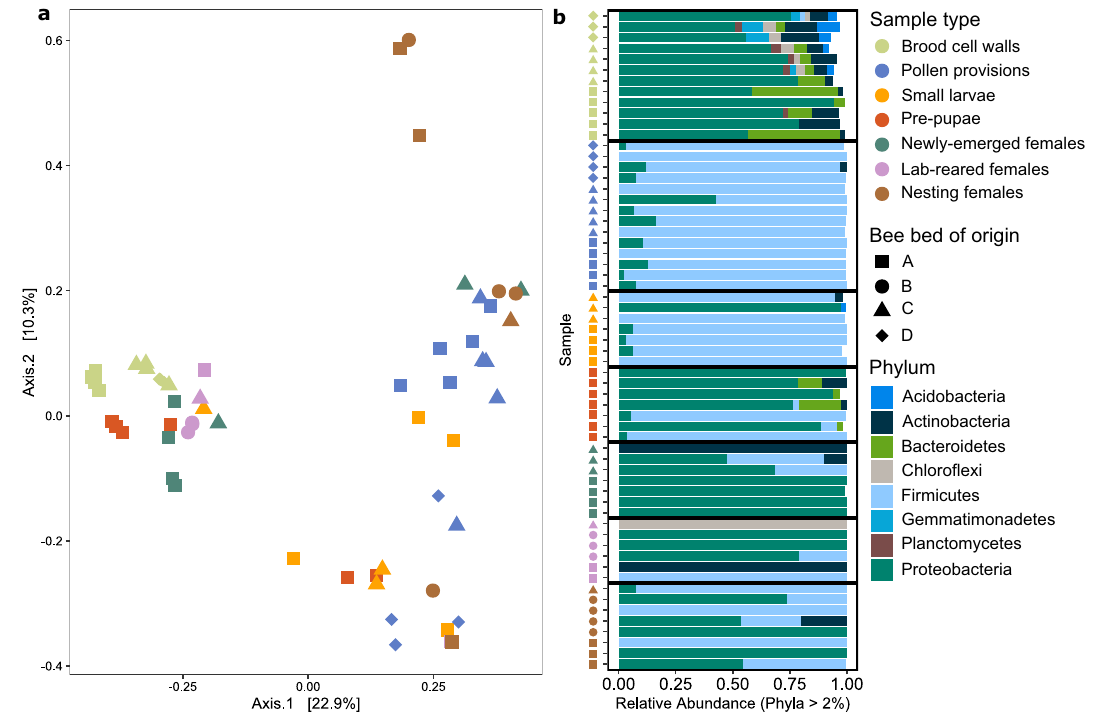
Figure 2. Microbiome composition across the alkali bee life cycle. ( a ) Principal coordinates analysis (PCoA) plot of Bray–Curtis dissimilarity from log-transformed abundances. Each point represents the bacterial community of an individual sample. ( b ) Relative abundance of Phyla found at greater than 2% abundance in each sample. Each row represents the bacterial community of an individual sample. Colors indicate sample type and shapes indicate bee bed from which sample was